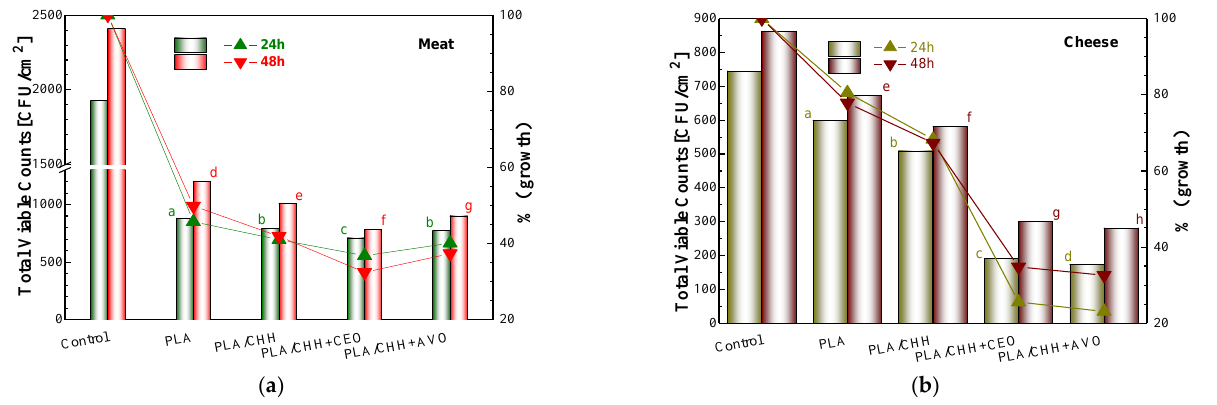
Figure 8. Variation in time of Total Viable Counts for beef meat ( a ) and white cheese ( b ) stored in contact with poly(lactic acid) unmodified and modified with oil-loaded chitosan coatings. The data are expressed as mean ± standard deviations from triplicate determinations. a–h Mean values with different letters indicate significant differences at p <